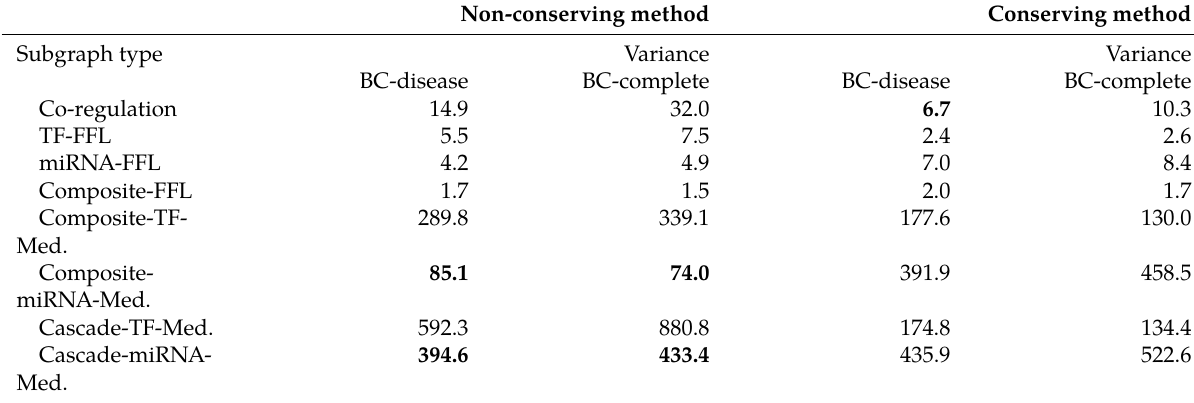
Table 3: Variance of count distributions of subgraphs in randomized networks for the BC-complete/-disease networks. Non-conserving method